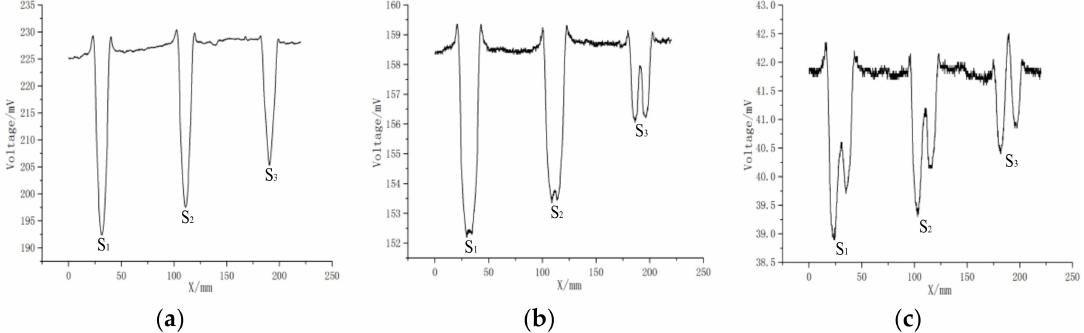
Figure 9. The signal strength diagrams with the multi-electrode sensor with 0.1mm lift-off: ( a ) E21, ( b ) E31, ( c )